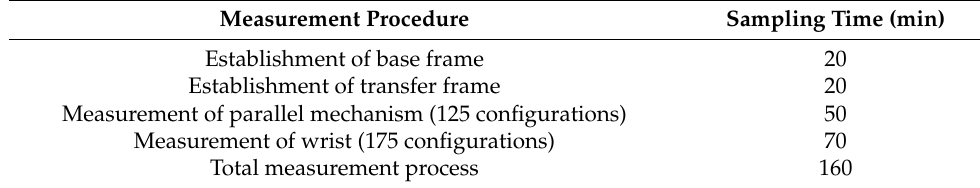
Table 3. Sampling time of the comparative